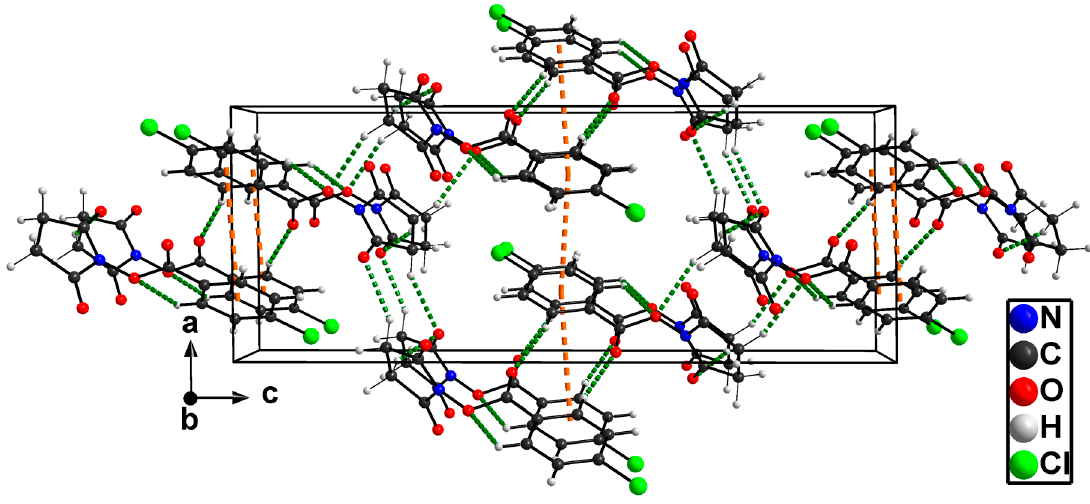
Figure 4. The packing of the molecules of 3b in an expanded view of the unit cell along the b axis. The shortest contacts between the phenyl rings are shown as brown dotted lines and the shortest intermolecular O....H distances as green dotted lines.